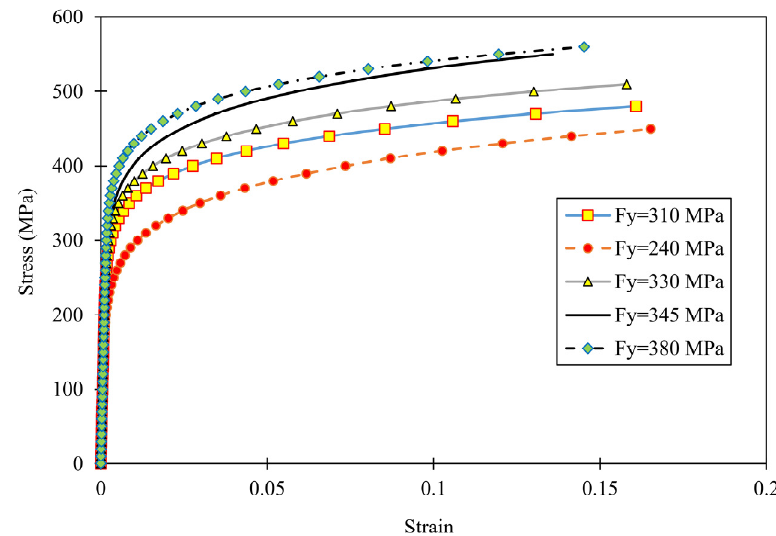
Figure 7. Stress–strain curves of steel materials.